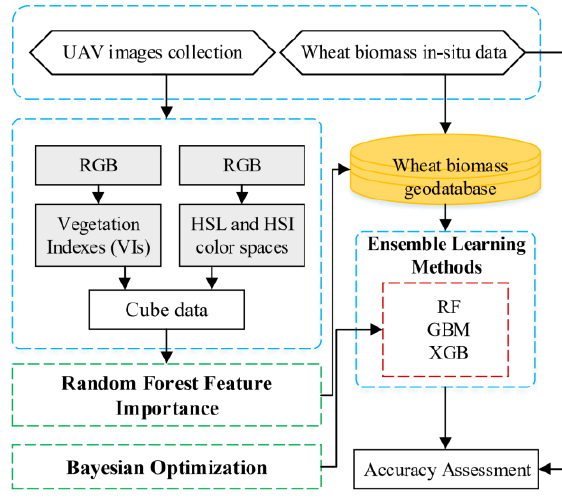
Figure 2. Flowchart of the proposed method.